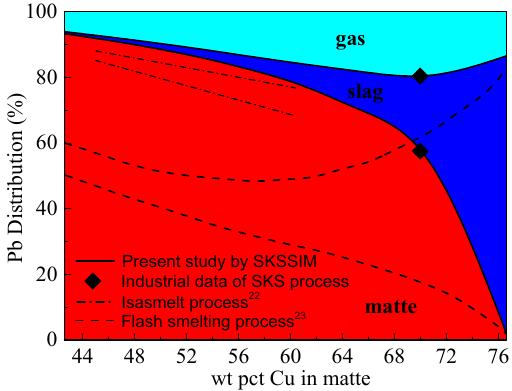
Figure 3. Lead (Pb) distribution in the SKS smelting process.